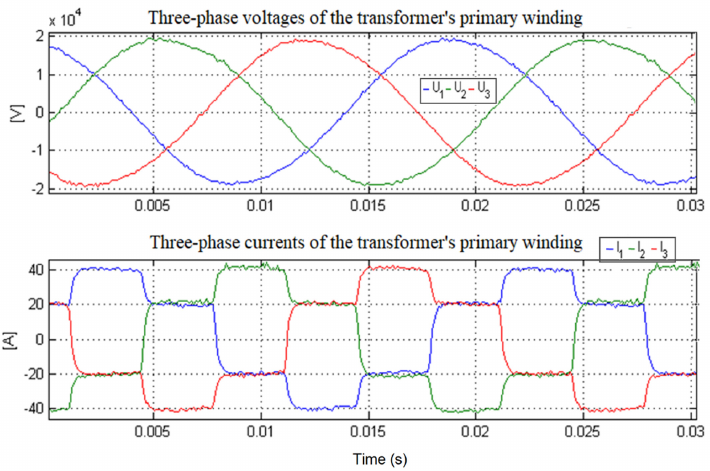
Figure 20. The three-phase voltages and currents acquired in the primary winding of the transformer for the excitation supply.